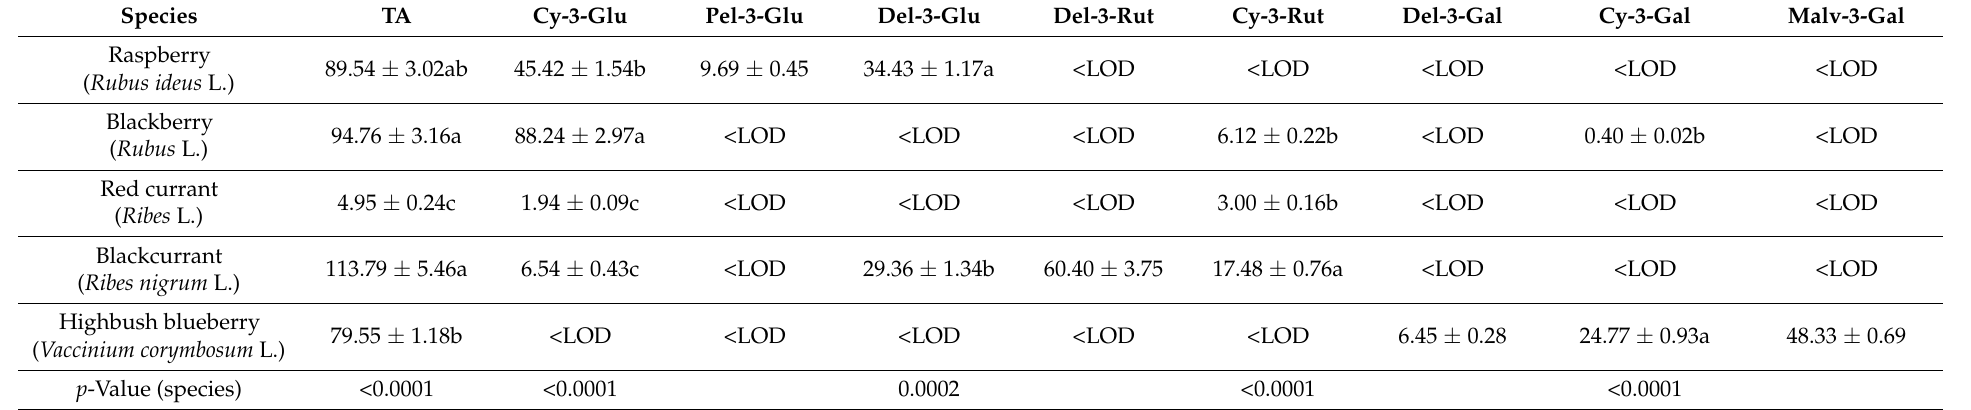
Table 2. The average content of individual anthocyanins in different species of berry fruits (in mg 100 g − 1 f.w.). Mean value ± SE.